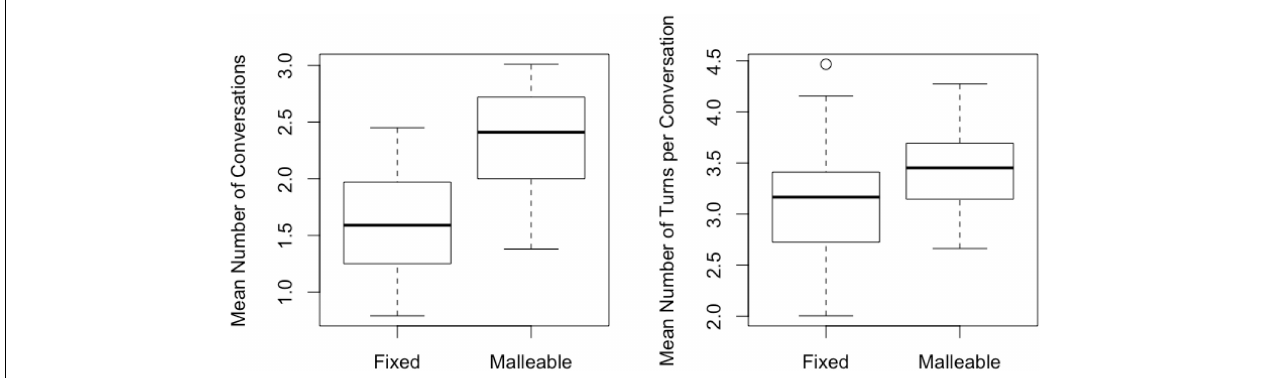
FIGURE 5 | Differences in gameplay based on generating model. On the left the mean number of conversations per game played; on the right the mean number of turns taken in each conversation. Each box represents the interquartile range with a median line and the whiskers represent 95% range given normality.